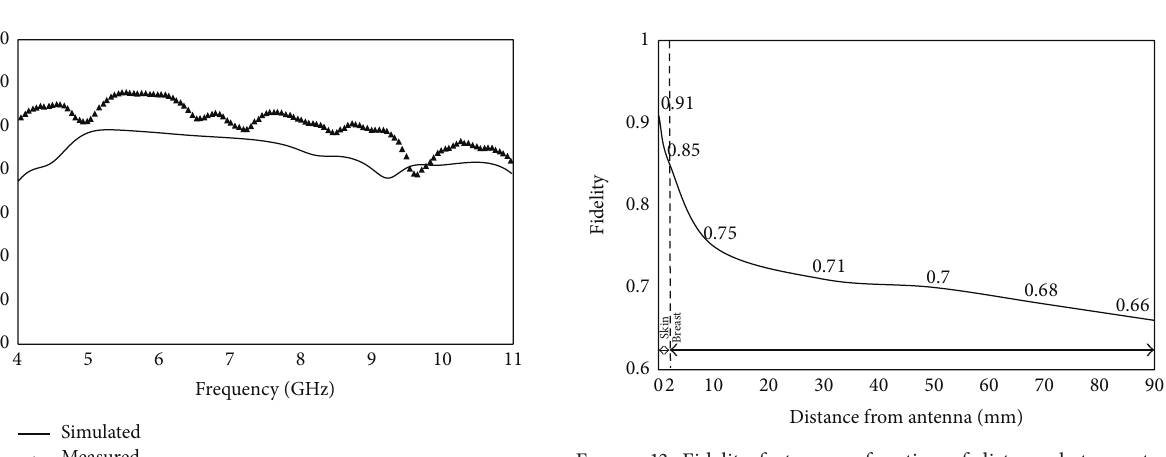
Figure 13: Fidelity factor as a function of distance between two